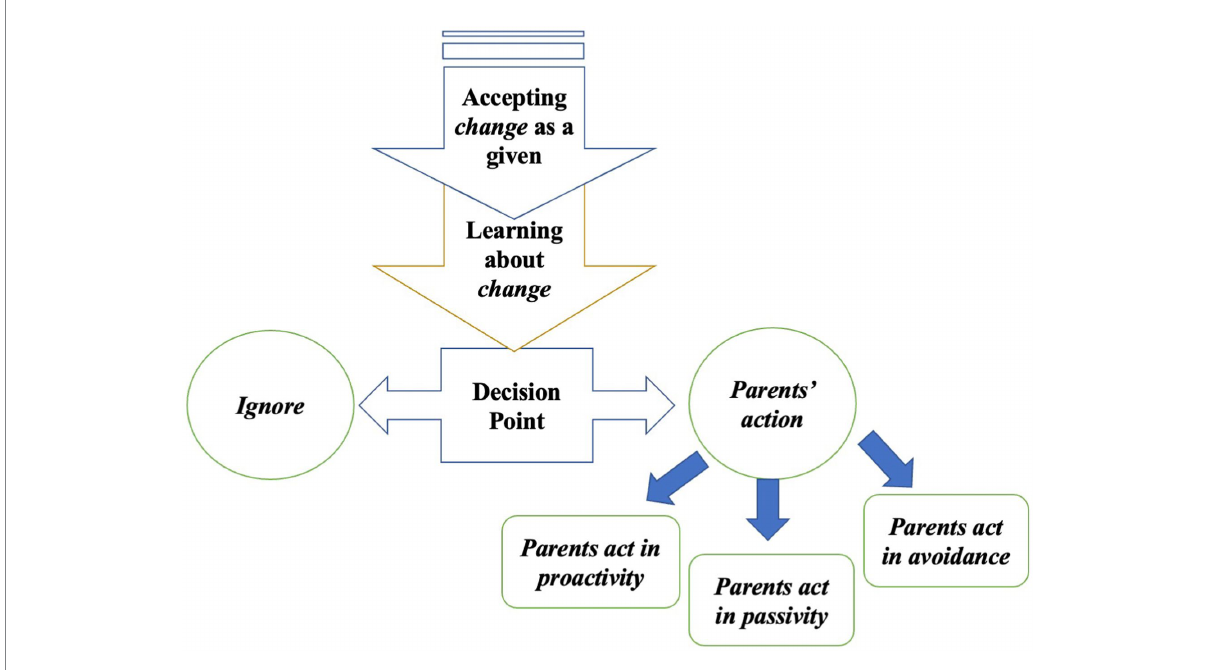
FIGURE 1 Framework of change and human actions (Fung, 2018, p. 100).